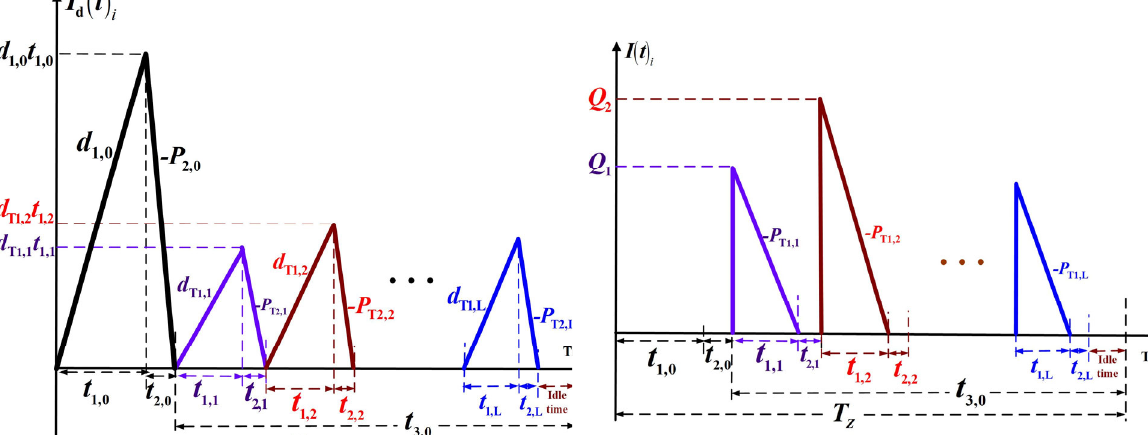
Fig. 2. The faulty stock level of this study Fig. 3. Standard part’s stock level when stage 2